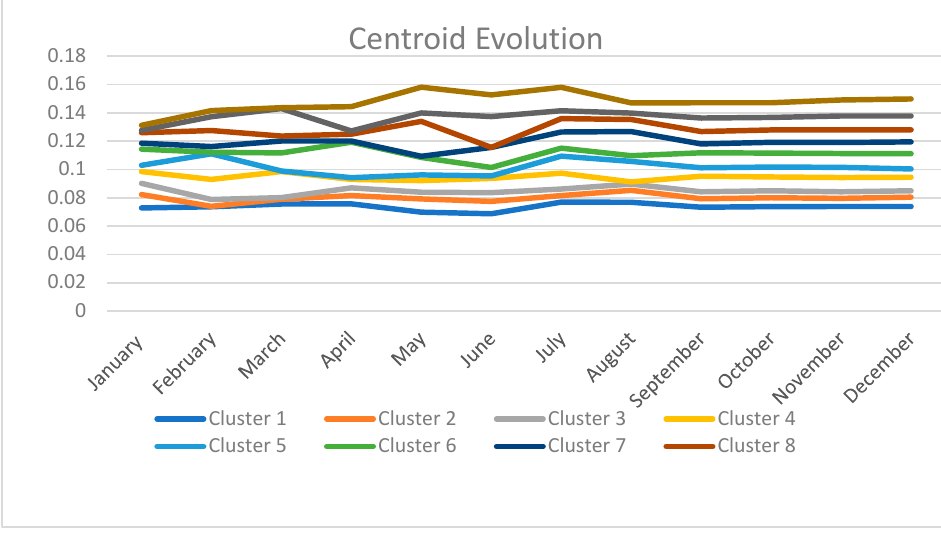
Figure 1. Evolution of the centroids of the first 10 groups with X-means.